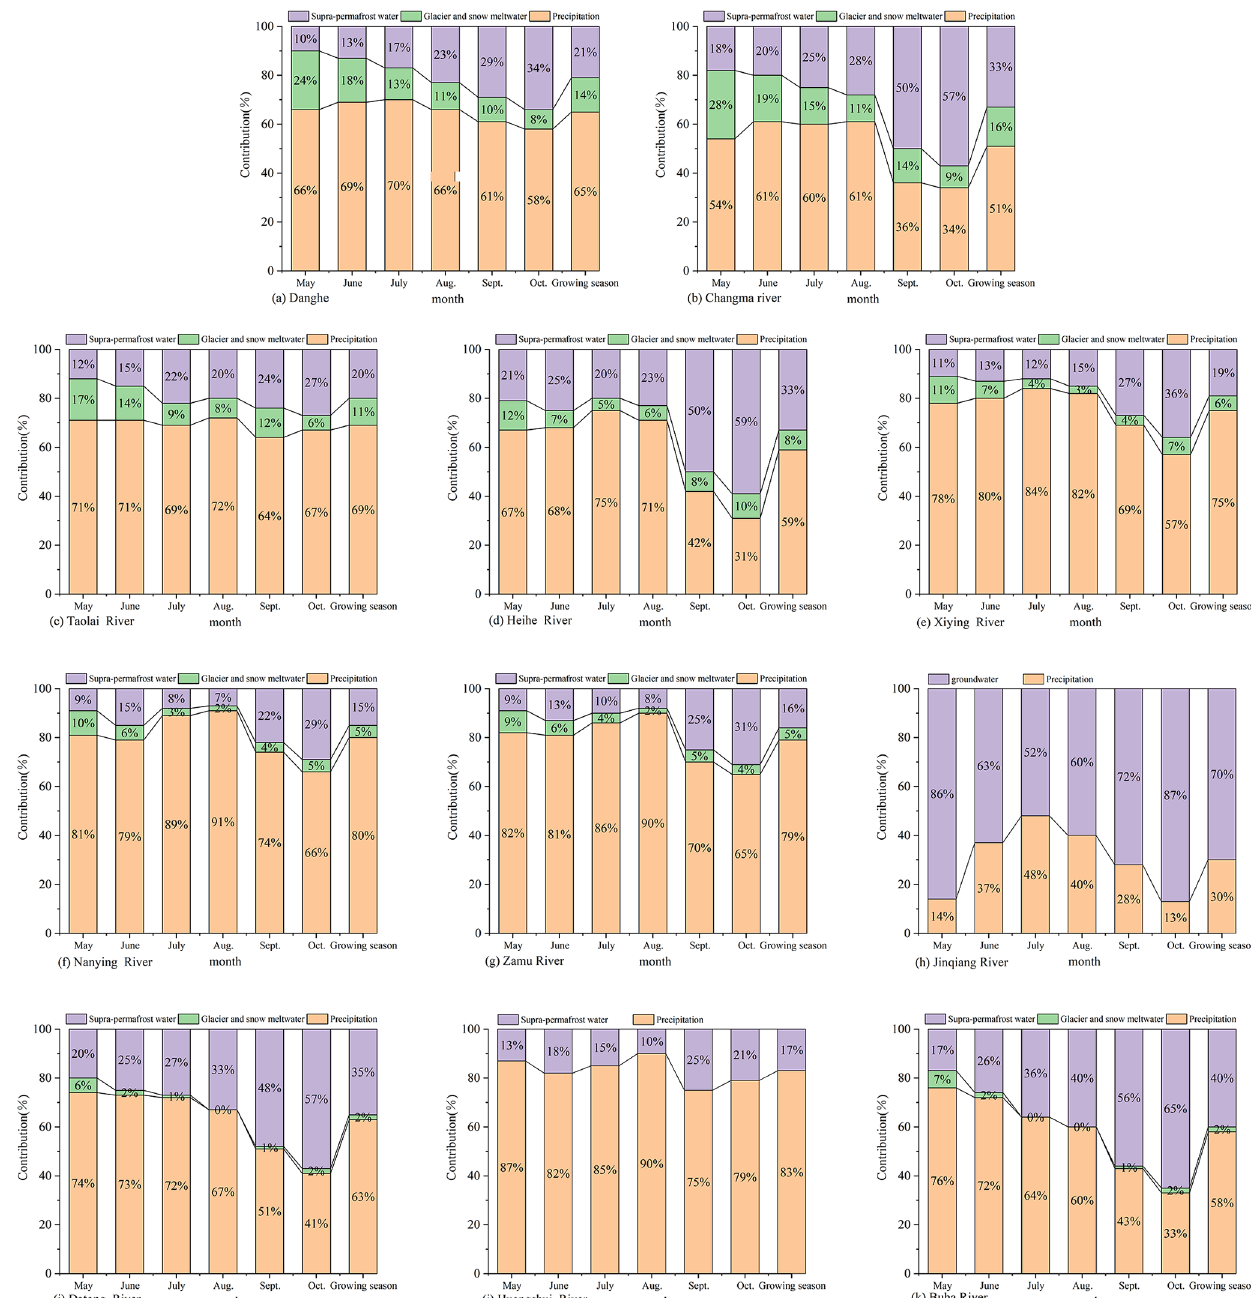
Figure 12. Contribution rate from runoff components to monthly